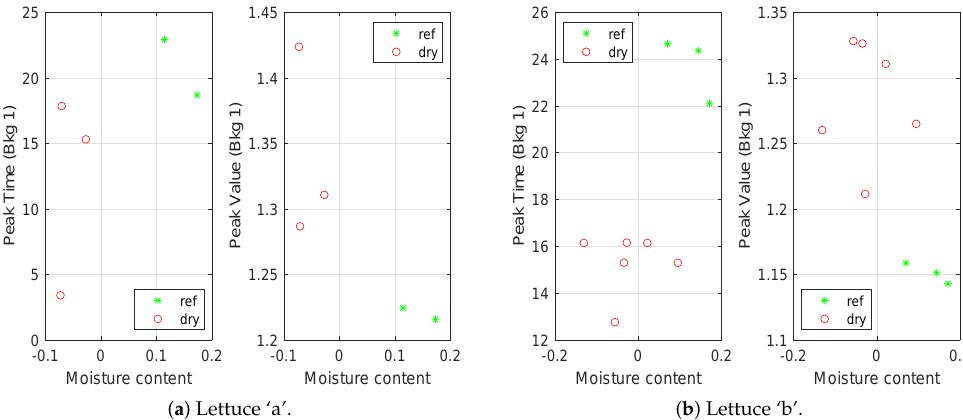
Figure 7. Peak time and peak value at the lowest background light level vs. the relative moisture content (higher value more irrigated) for ( a ) lettuce ‘a’ and ( b ) lettuce ‘b’. In an additional setup, lettuce ‘c’ and lemon balm were evaluated for salt stress.